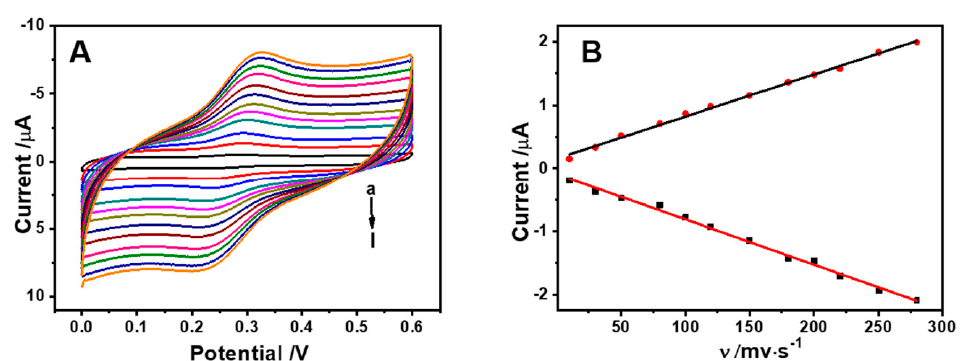
Figure 6. ( A ) CVs of UiO-66/ErGO/GCE in the presence of 0.5 μ M of LU (pH = 6.0) at different scan rates ranging from a to l (0.01 to 0.275 V s − 1 ). ( B ) Correlation between peak current vs. scan rate.